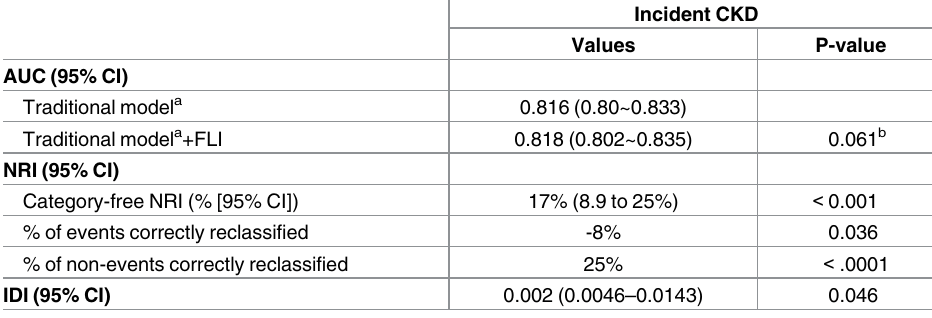
Table 4. Discrimination and reclassification improvement for incident CKD by